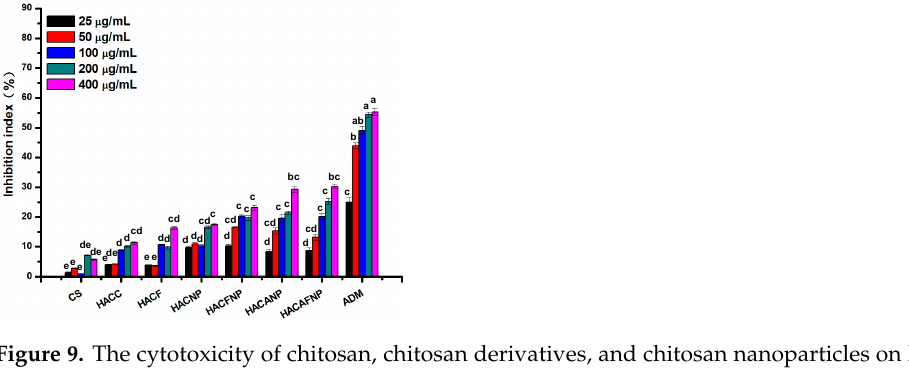
Figure 9. The cytotoxicity of chitosan, chitosan derivatives, and chitosan nanoparticles on HTR-8 cells (normal cells). Data are presented as mean value ± SD. Letters that are different in Figure 9, according to various sample concentrations, differ statistically between different samples (p < 0.05).